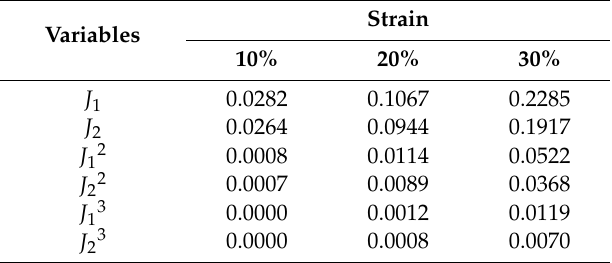
Table 1. Values of the stain invariants of a hyperelastic material against uniaxial tensile strain. Strain Variables